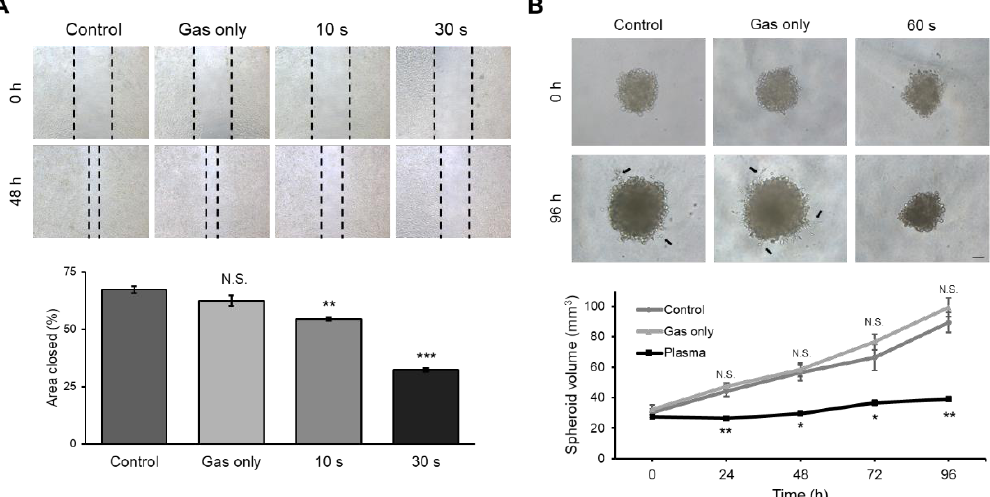
Figure 5. Migration and invasion activity of D-17 cells after exposure to cold atmospheric plasma (CAP). ( A ) Cell migration assay. Representative images of cells before and after exposure to CAP. Magnification, 40X. Quantitative analysis of the area refilled after 48 h. The graph represents three independent experiments. Error bars represent the mean ± S.E.M. ( B ) Three-dimensional tumor spheroid invasion assay. Representative images of spheroids before and after exposure to CAP. Invadopodia were observed in control and gas-treated group (black arrow). Scale bar, 100 µ m. Volume of the control or CAP-treated spheroids was measured and is presented as a graph. Error bars represent the mean ± S.E.M. of three replicates. * p < 0.05, ** p < 0.01, *** p < 0.001, compared to control; N.S. indicates not significant.